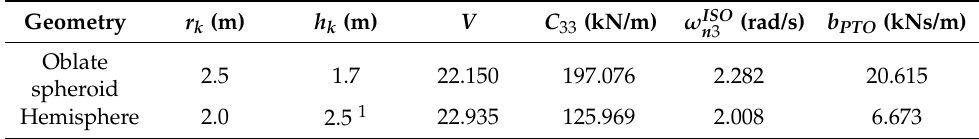
Figure 4. Examined layout of the array with M = 4 WECs. Table 1. Geometrical and hydrodynamic properties of WEC geometries examined.